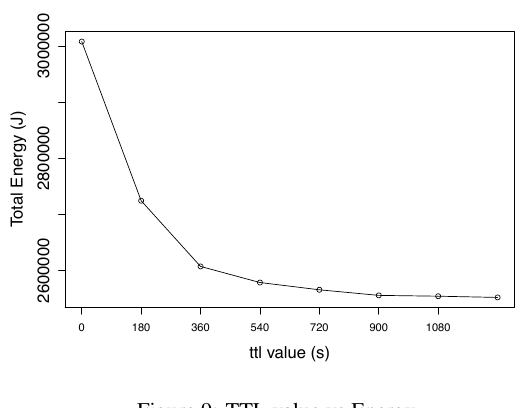
Table 3: Latency versus Energy Saving with the Scheduling Con-